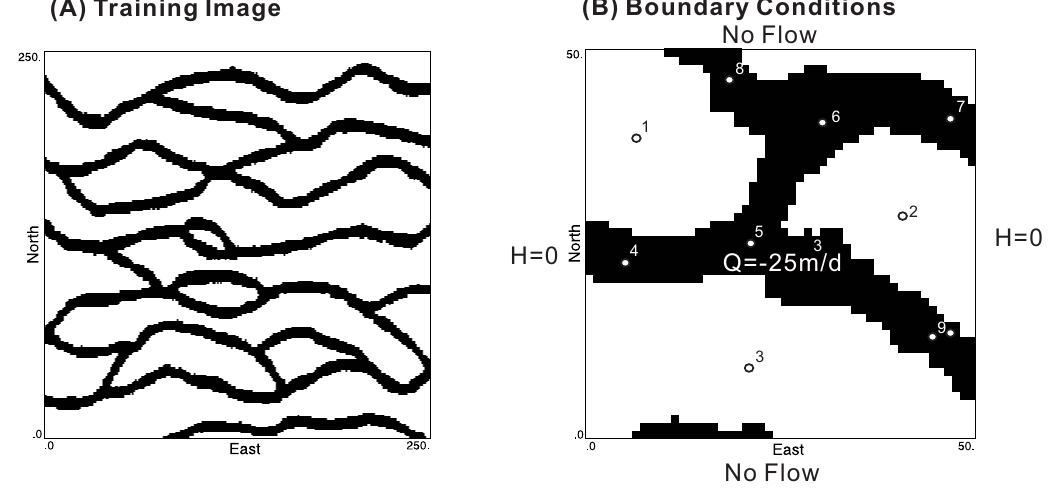
Figure 3. ( A ) Training image for the reference field; and ( B ) its boundary